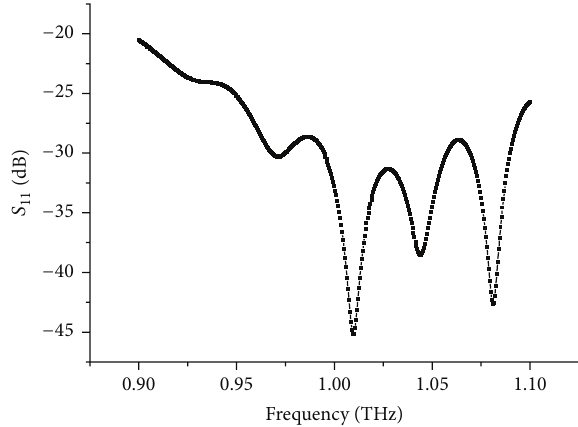
Figure 7: The gain of the 300 GHz antenna for different lengths.